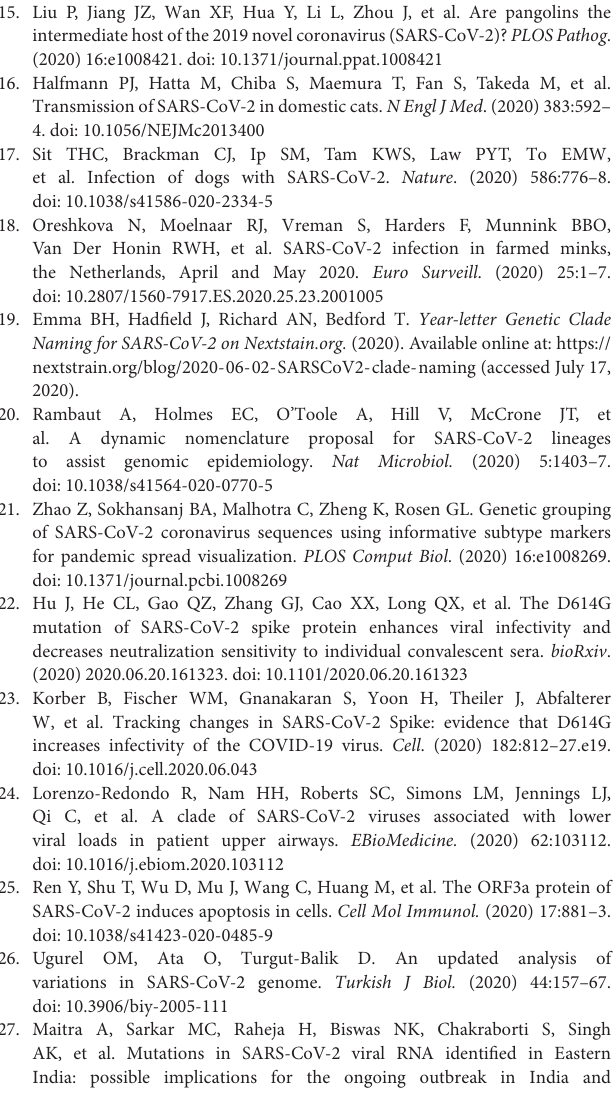
Supplementary Figure 1 | Methodological strategy plan for SARS-CoV-2 genome analysis based on different next-generation sequencing methods. Supplementary Figure 2 | Mutational landscape of Latvian SARS-CoV-2 isolates. y -axis shows the mutated position of a reference SARS-CoV-2 genome. x -axis shows the cumulative mutation count at a given position. Number to the right of bars indicate cumulative mutation count at a given position, and bars are color-coded according to the protein that the corresponding site participates in encoding. Note, that y -axis is discrete and only positions with mutations documented in local isolates are shown. Supplementary Figure 3 | Root-to-tip regression analysis of 133 Latvian SARS-CoV-2 isolates and Wuhan-Hu-1 sequence.